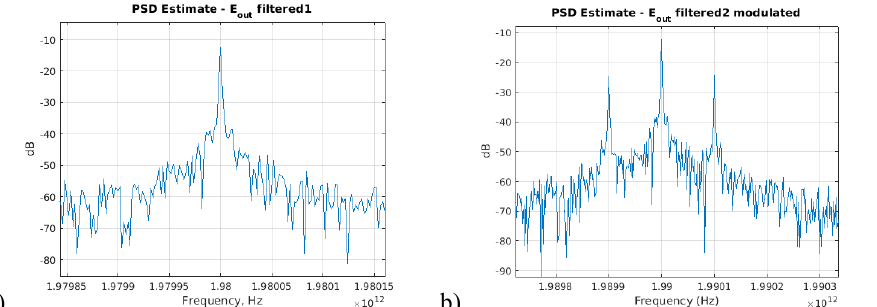
Fig. 5. Spectral densities of two optical modes used to form a modulated microwave signal: mode without modulation (a) and mode with amplitude modulation with frequency 100 MHz